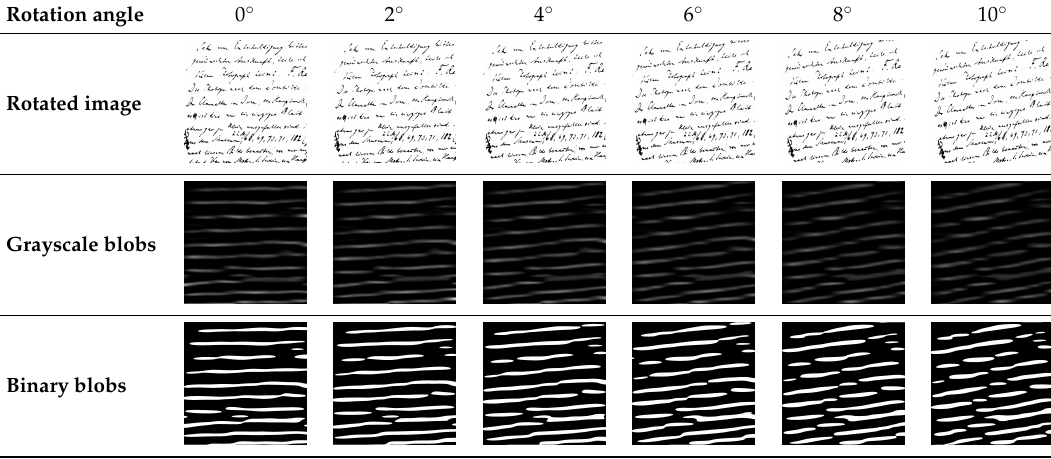
Figure 4. The effectiveness of horizontally elongated filters on text lines with varying